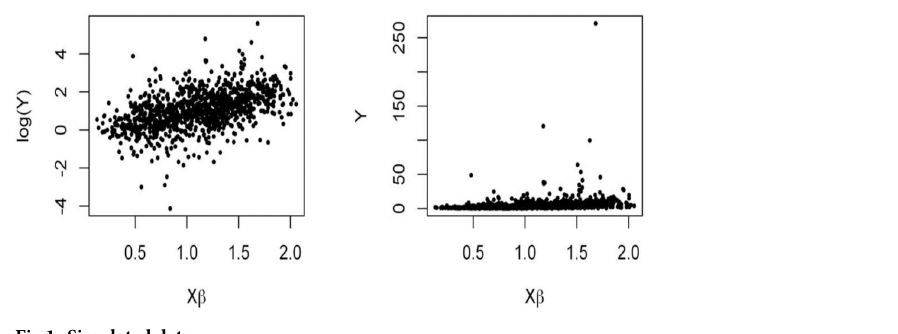
Fig 1. Simulated data.